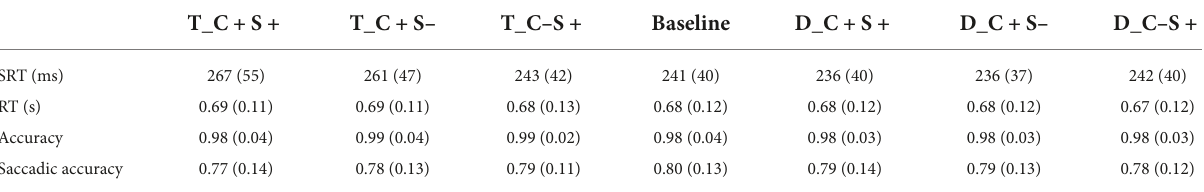
TABLE 1 Mean saccadic reaction time (ms) and reaction time (s) and accuracy and saccadic accuracy for all condition of Exp.1A (standard deviations are within